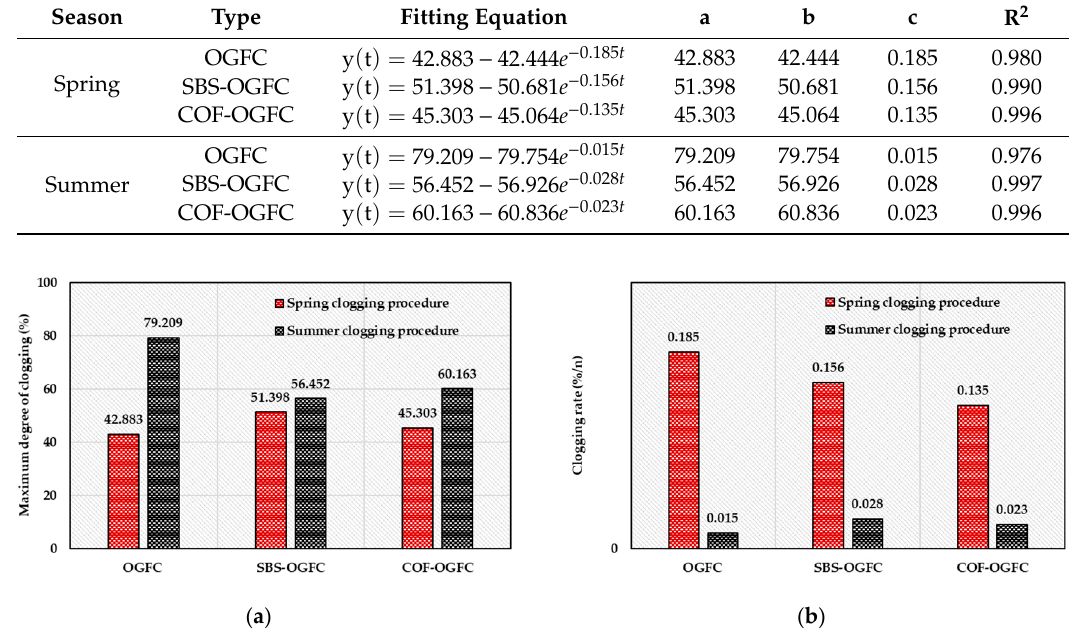
Figure 12. Clogging parameters of three mixtures in summer and spring season. ( a ) Maximum degree of clogging; ( b ) Clogging rate.